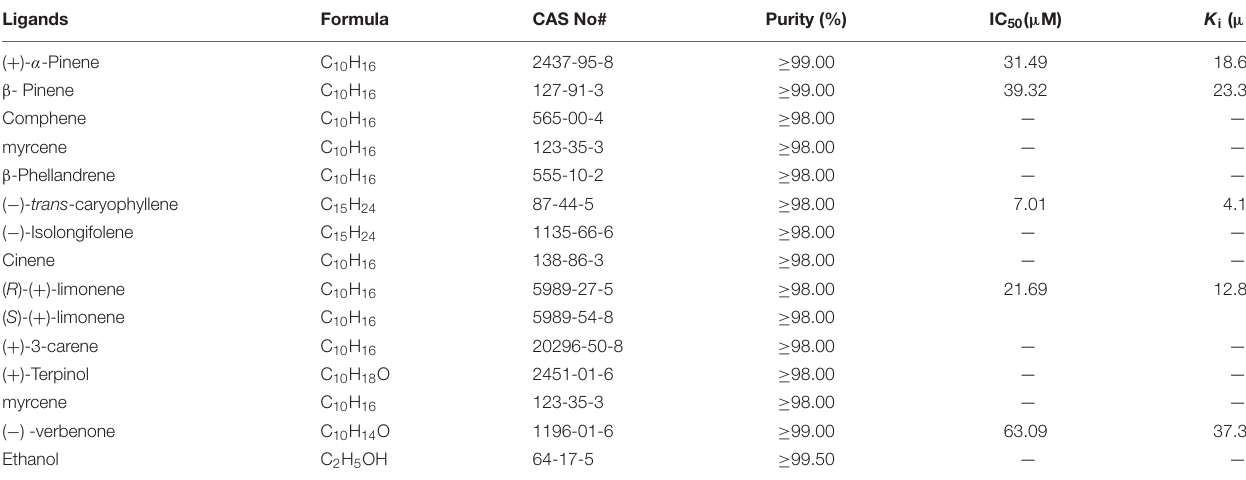
TABLE 1 | Binding affinity of selected compounds to the recombinant